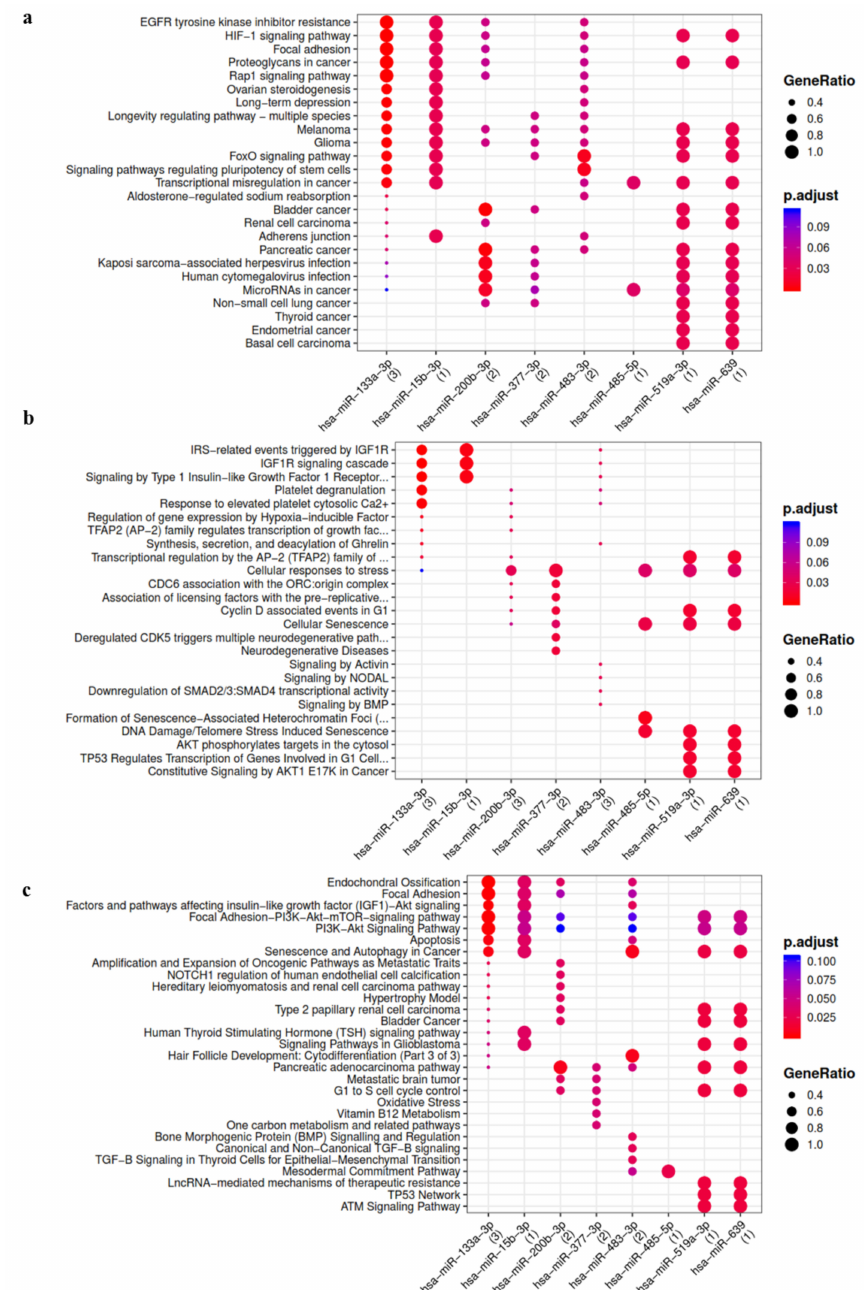
Figure 2. Functional enrichment analysis on miRNA activated in ASC-EVs primed with IL-1 β . The analysis was conducted by KEGG pathway ( a ) Reactome ( b ) and Wikipathway ( c ). Significant path- ways are listed and represented by circles colored according to the significance of the enrichment and their size is proportional to the number of target genes regulating the described signaling